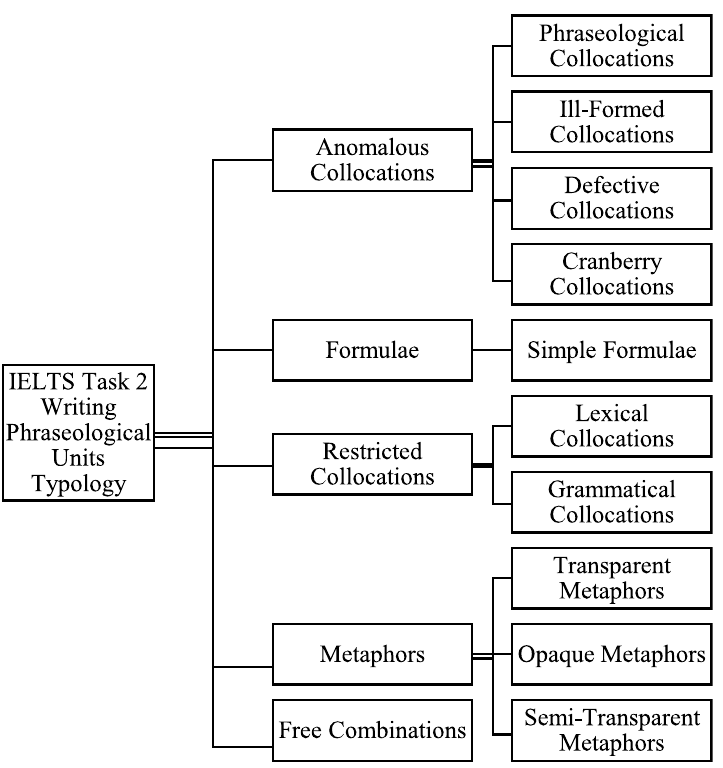
Fig. 9 Proposed typology for the use of phraseological units in IELTS task 2 writing